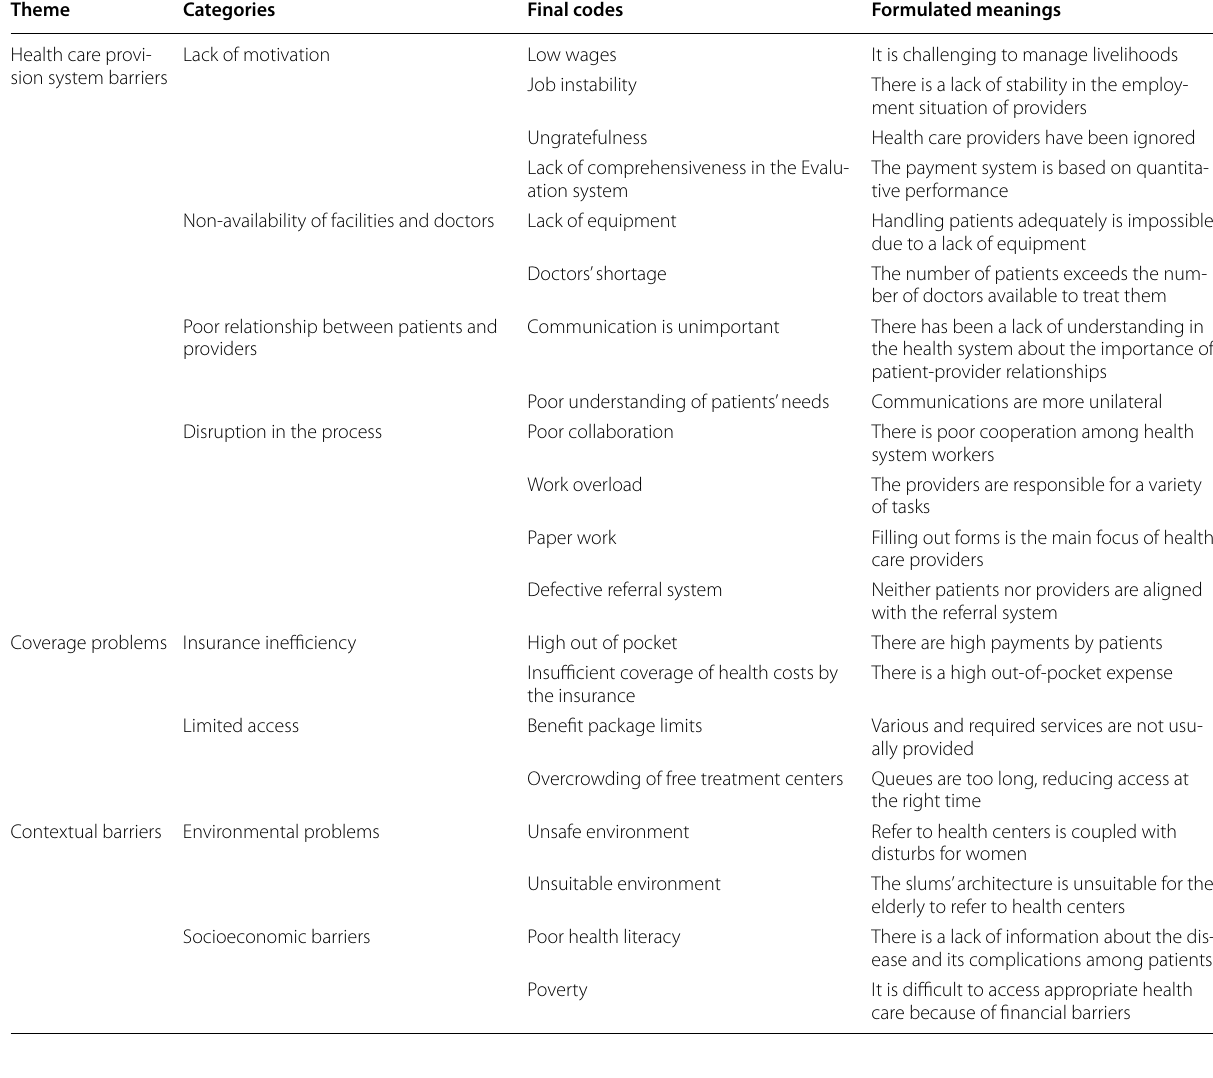
Table 1 Themes, categories, codes, and formulated meanings Theme Categories